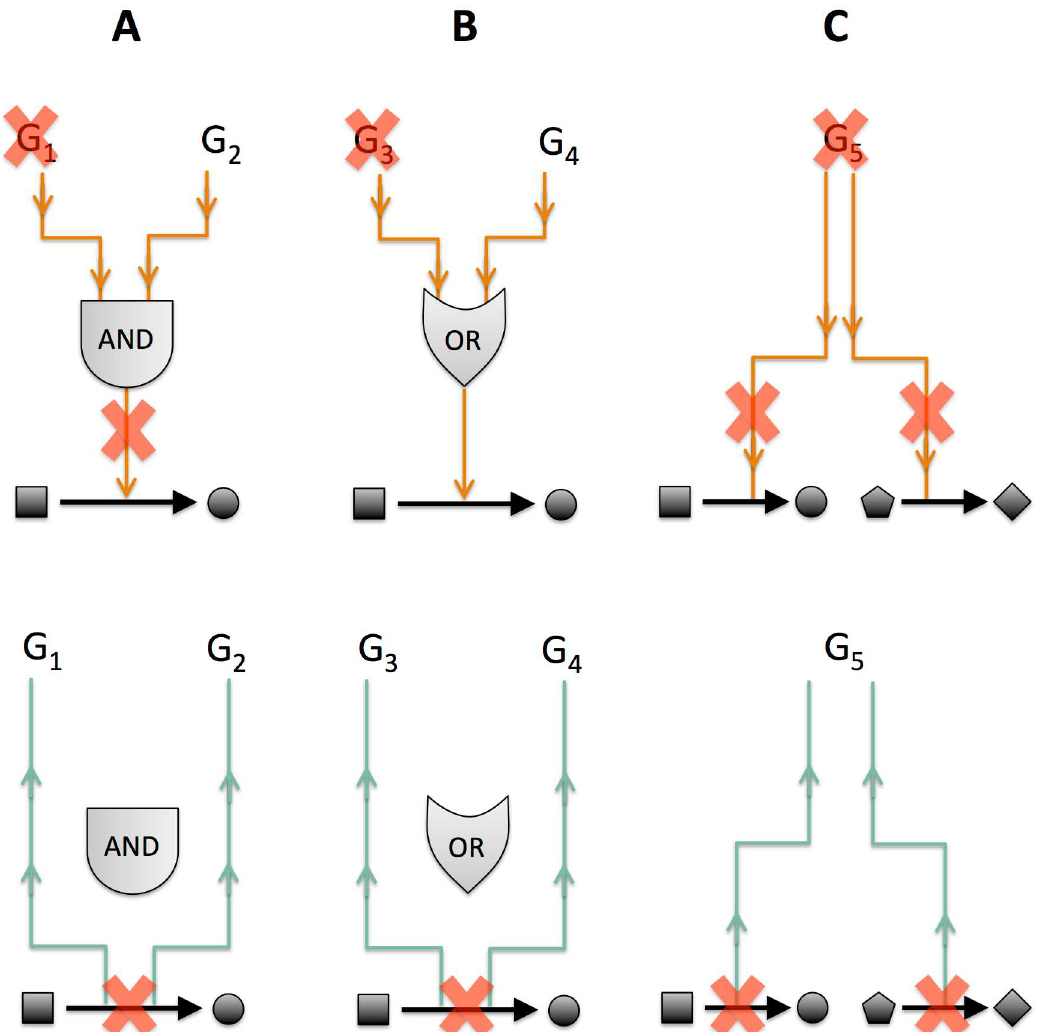
Fig 1. Comparison of the gene dispensability metrics:function-loss cost and gene-loss cost. Each toy scenario (A–C) representsa possiblegene-to-reactionmappingconfiguration in its simplest form. Gene-losscost (orange arrows, top row) propagates gene deletions“downwards” through logic gates to determine which reaction(s) are removedfrom the network, which in turn determine model fitness predictions. Function-loss cost (green arrows, bottom